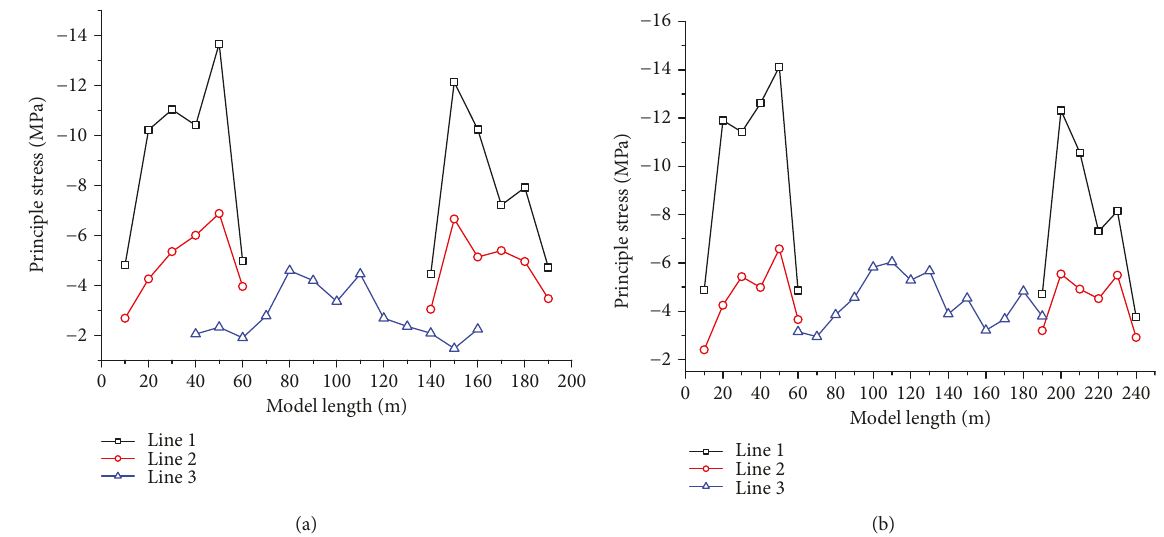
Figure 13: The distribution of the principle stress with the working face advancing in surrounding rock. (a) Advancing 90 m. (b) Advancing